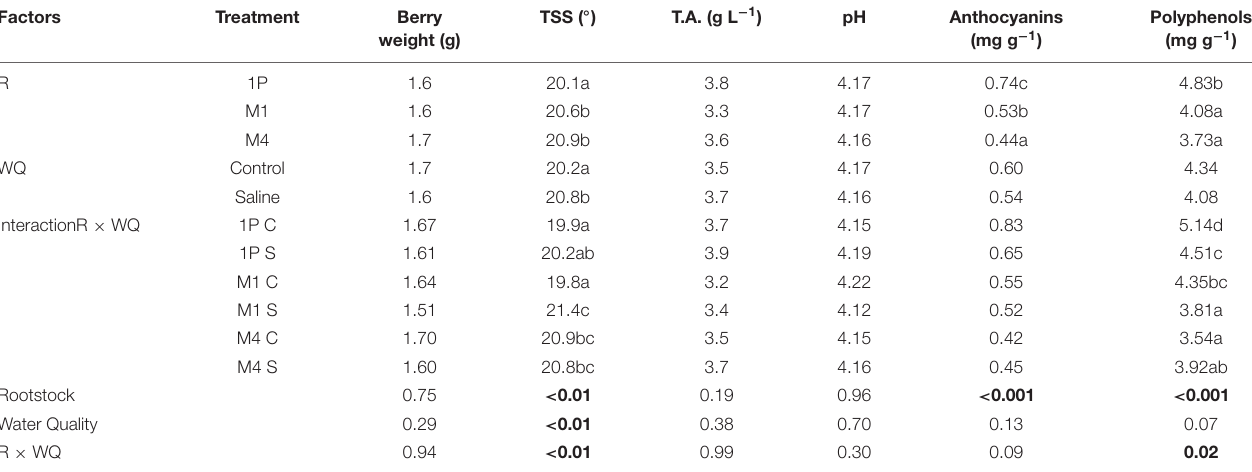
TABLE 3 | Parameters of grape composition at harvest for Tempranillo wine grapes grafted onto M1, M4, and 1103-Paulsen (1P) rootstocks subjected to different water quality (C; control and S; saline irrigation) in Valencia, Spain.